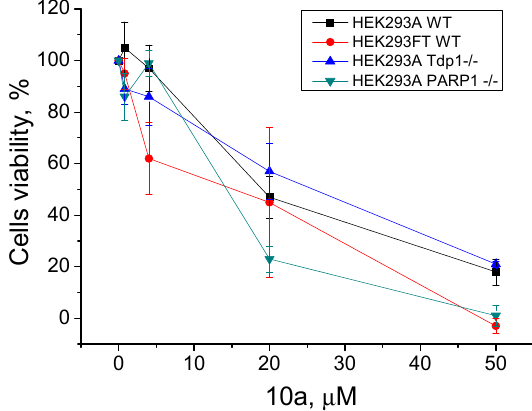
Figure 6. Intrinsic cytotoxicity of 10a on HEK293FT and HEK293A cells, as well as on the Tdp1 and PARP1 knockout HEK293A cell lines (HEK293A Tdp1 -/- and HEK293A PARP1 -/-); the dose- dependent action. The values were normalized to the control wells with the cells in 1% DMSO.